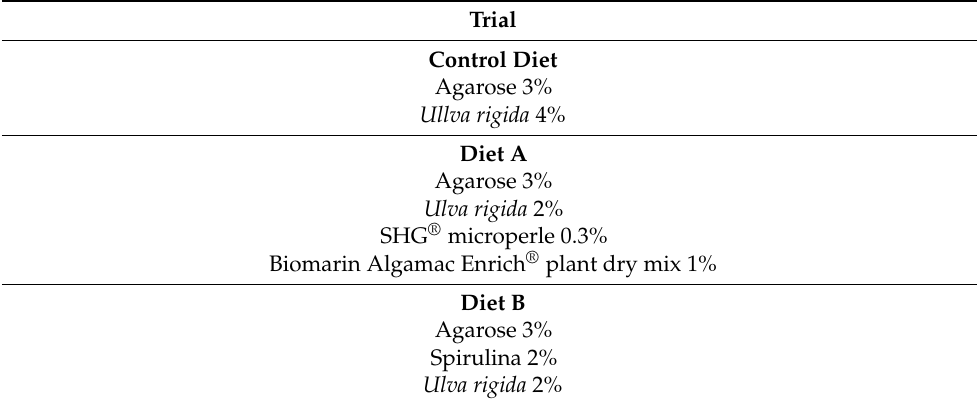
Table 1. The ingredient composition (weight expressed in percentage) of two diets tested on P. lividus post-larvae, offered in an agarose matrix. Diets indicated with the letters A and B were consistently compared to a control diet containing only the common alga Ulva rigida often used as a convenient feeding substrate for sea